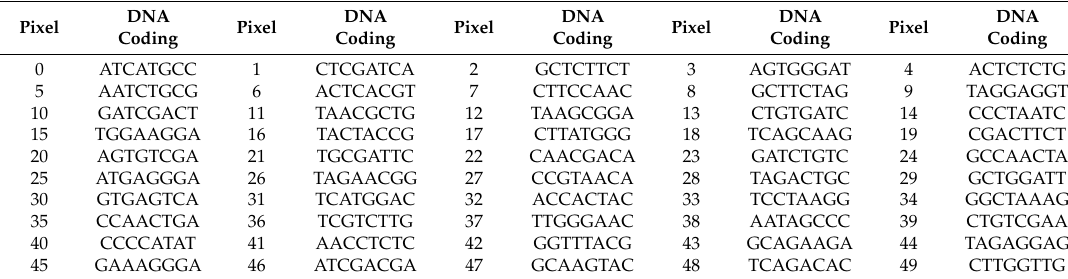
Table 2. The first 50 DNA coding